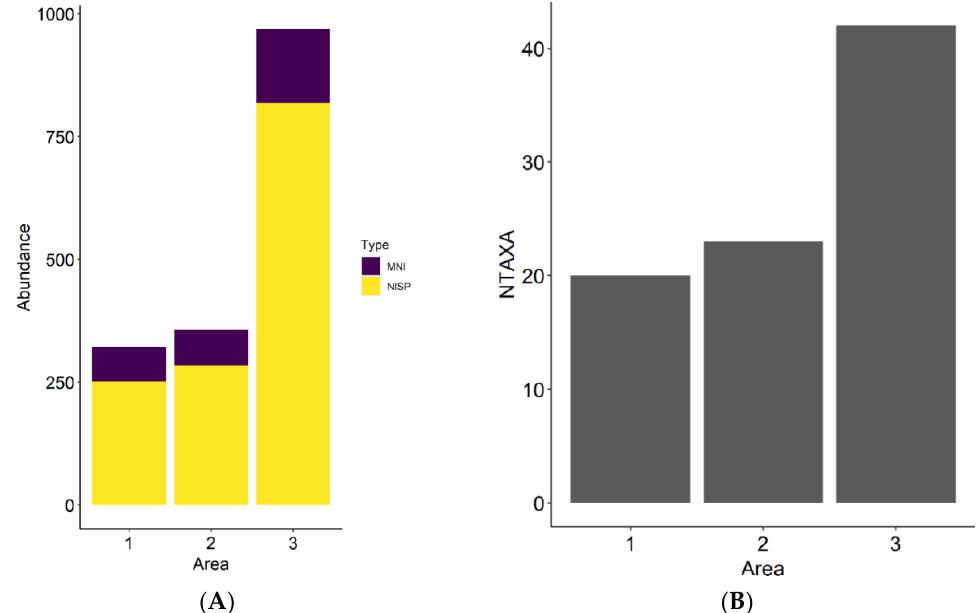
Figure 5. Abundance of fauna and number of identified taxa identified in each area at Ban Rai Rock- shelter: ( A ) abundance (NISP, number of identified specimens and MNI, minimum number of indi- viduals) of faunas; ( B ) number of identified taxa (NTAXA).